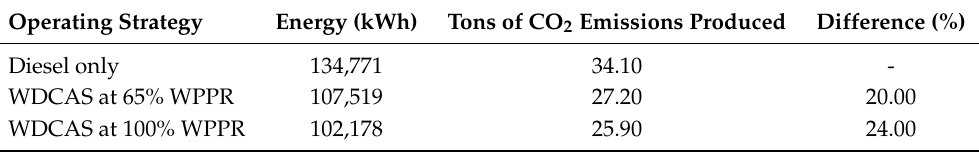
Table 13. Environmental impact of using